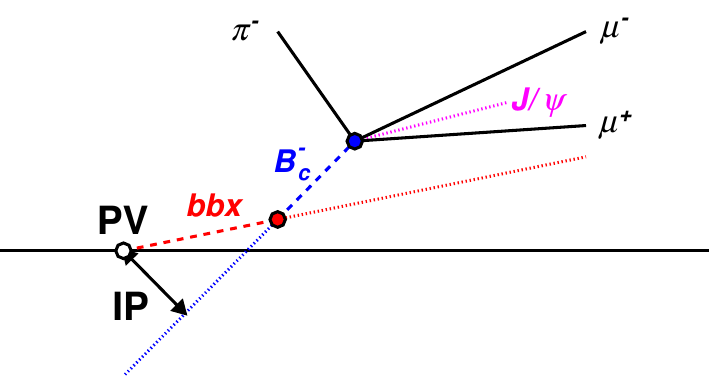
Figure 2 . Illustration of the non-zero IP associated with B (cid:0) hadrons. Additional particles produced in the bbx decay are not shown. Reconstruction of the B (cid:0) decay vertex position and momentum vector from the J= (cid:25) (cid:0) (cid:12)nal state particles alone is su(cid:14)cient to determine the